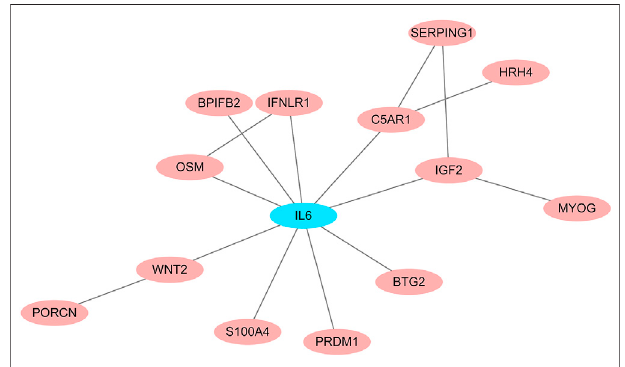
FIGURE 5| PPI networks for IL-6 and IL-6 related genes with the top 50 highest correlation coef fi cients.